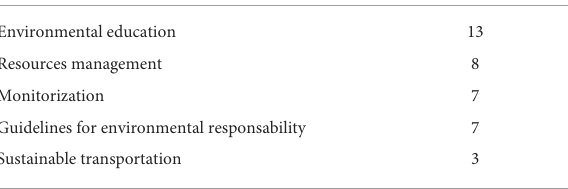
TABLE 2 Environmental sustainability practices per nautical